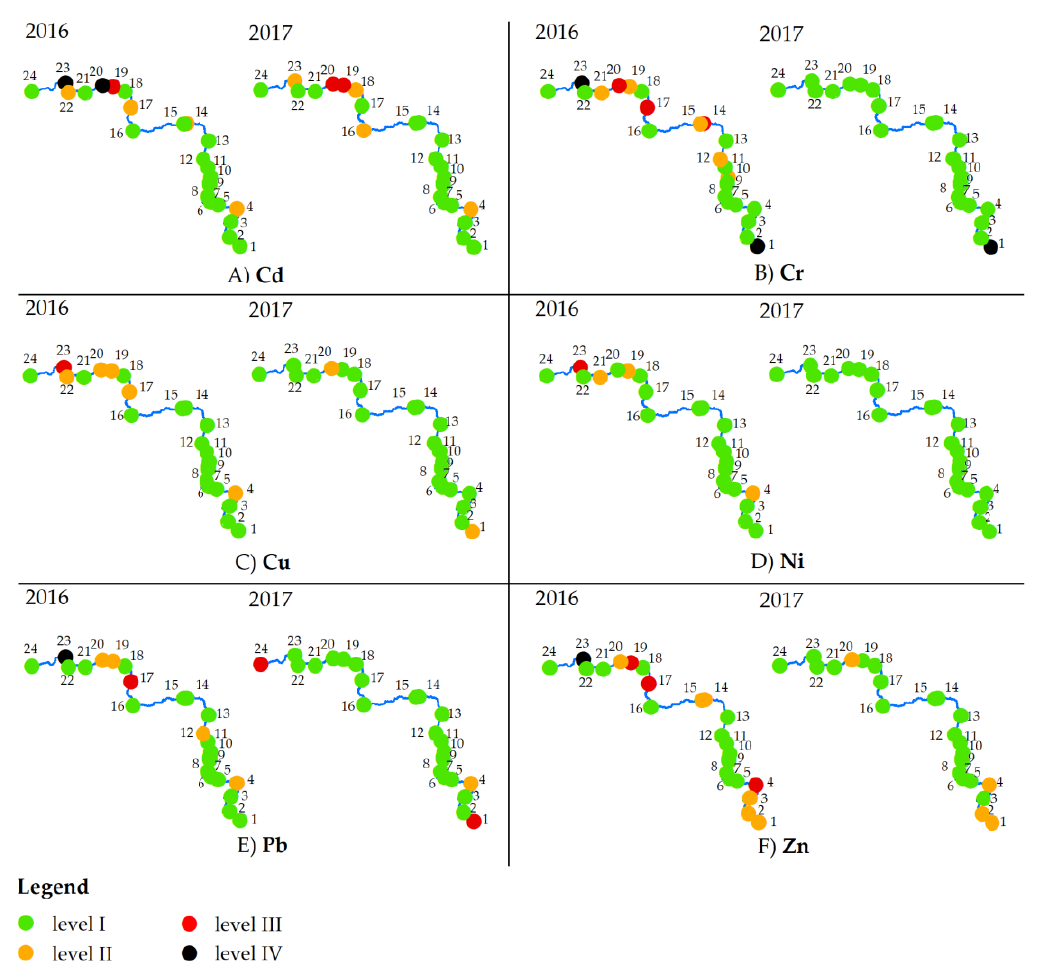
Figure 9. Ecotoxicological criteria for assessing the lakes quality using TEC, MEC, and PEC values in bottom sediments of Warta River in 2016 and 2017.